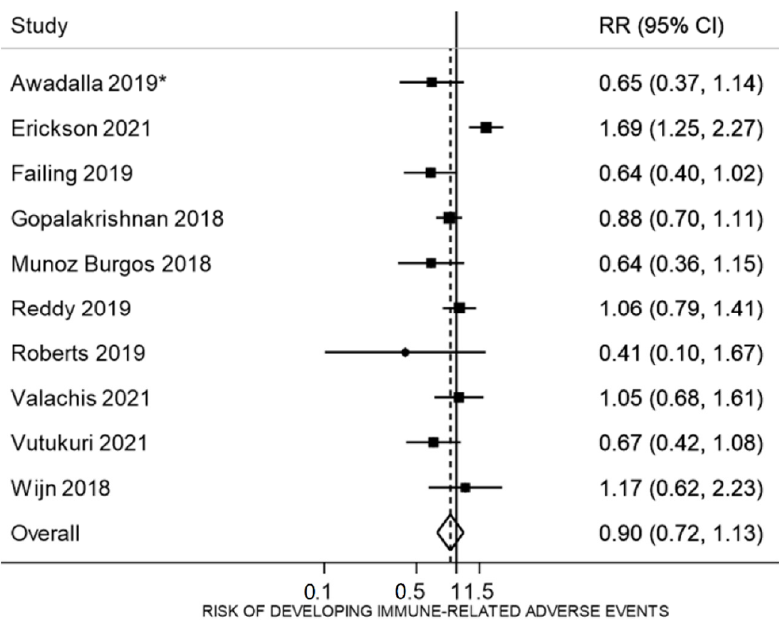
Figure 3. Risk of developing an immune-related adverse event in patients receiving immune checkpoint inhibitors who were vaccinated compared with those who were not vaccinated. * Awadalla et al., 2019 reported rates of any type of irAEs in patients who already had myocarditis due to the immune checkpoint inhibitor.